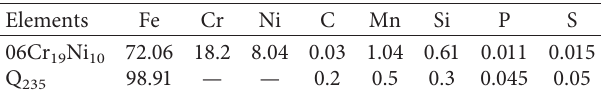
Figure 6: Experimental procedures of pilger hot rolling clad tube. (a) Blank forming. (b) Hot rolling process. (c) Sampling positions. 1, pumping tube; 2, seal weld; 3, carbon steel; 4, stainless steel. Table 2: The chemical composition of carbon steel and stainless steel (wt%).